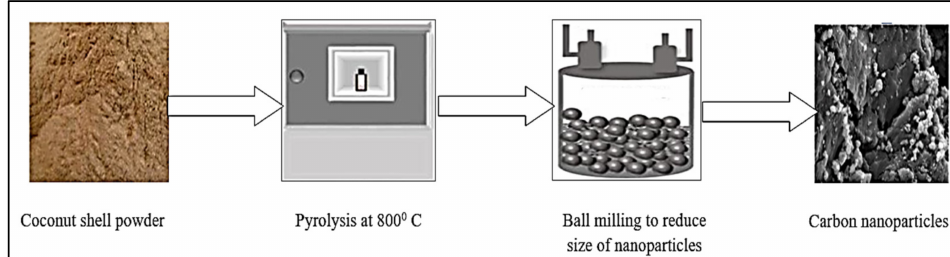
Figure 9. Synthesis of carbon nanoparticles from CS